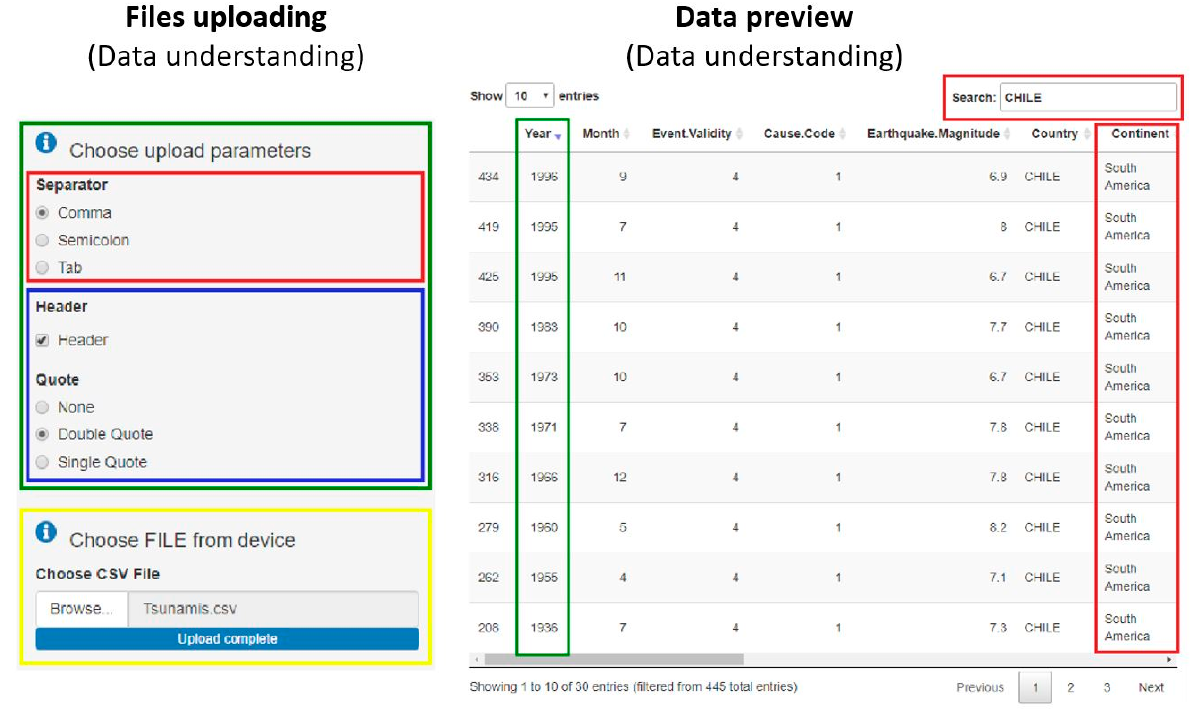
Figure 5. Files uploading and data preview (data understanding).